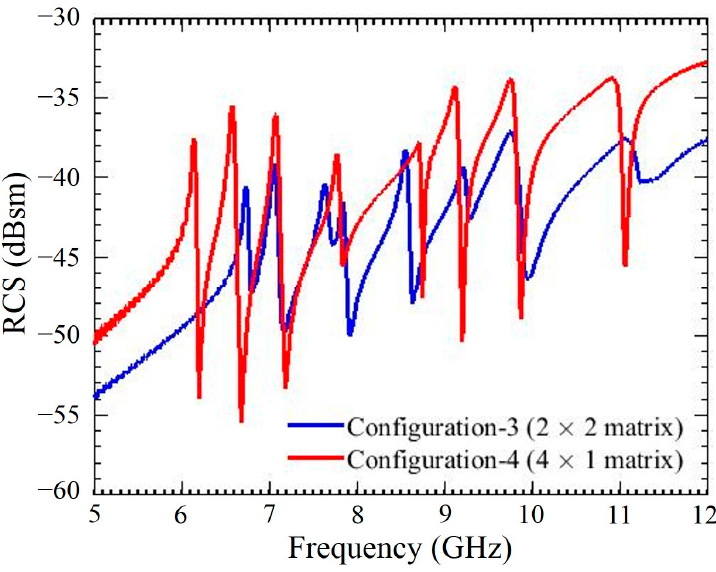
Figure 9. Simulated RCS response of Configuration-3 and Configuration-4.